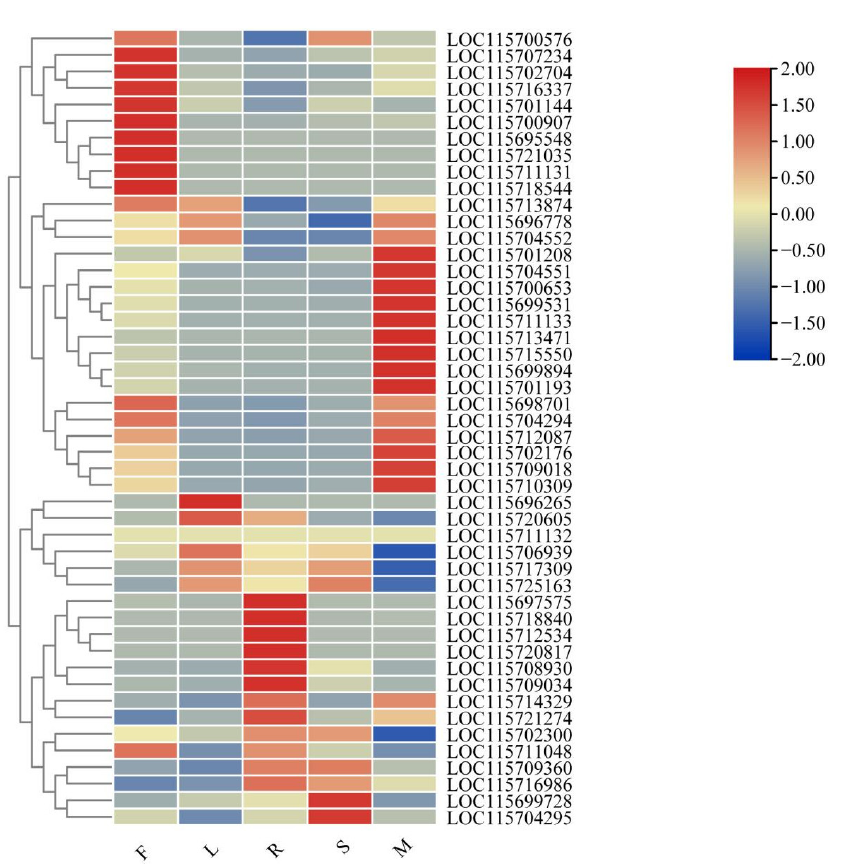
Figure 7. Heatmap of gene expression of MADS transcription factors in different tissues of cannabis (R: root; S: stem; L: leaves; F: female; M: male).